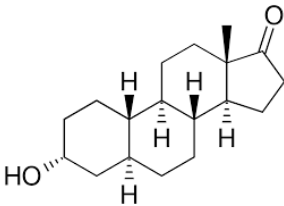
Figure 31. Chemical structure of 19-norandrosterone. Formula: C 18 H 28 O 2.